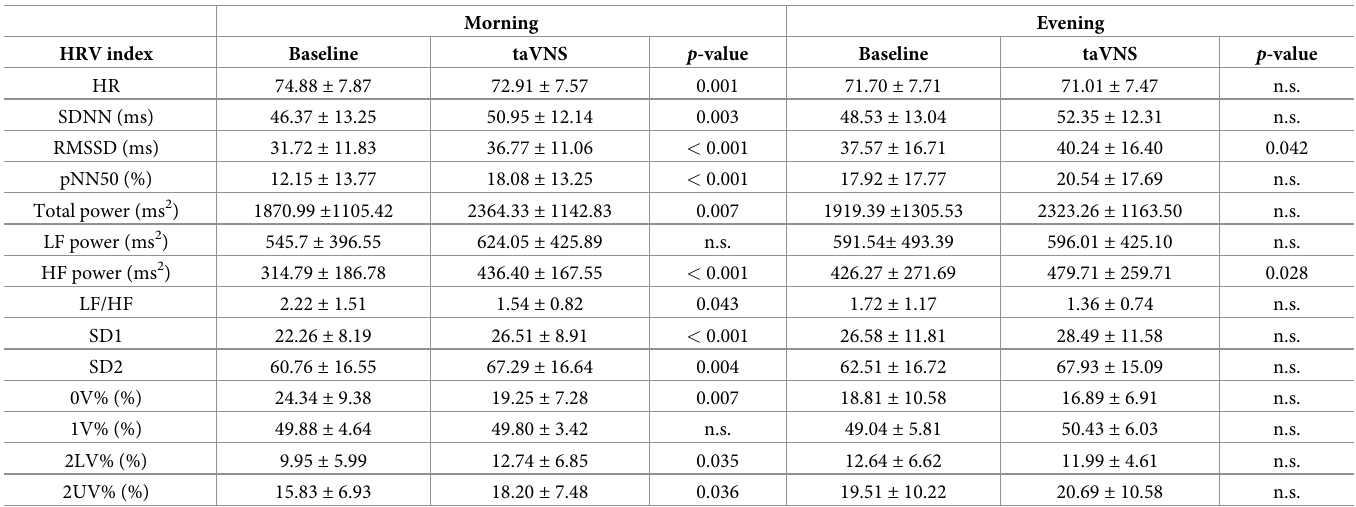
Table 2. Measurements of different HRV indices between the two groups.